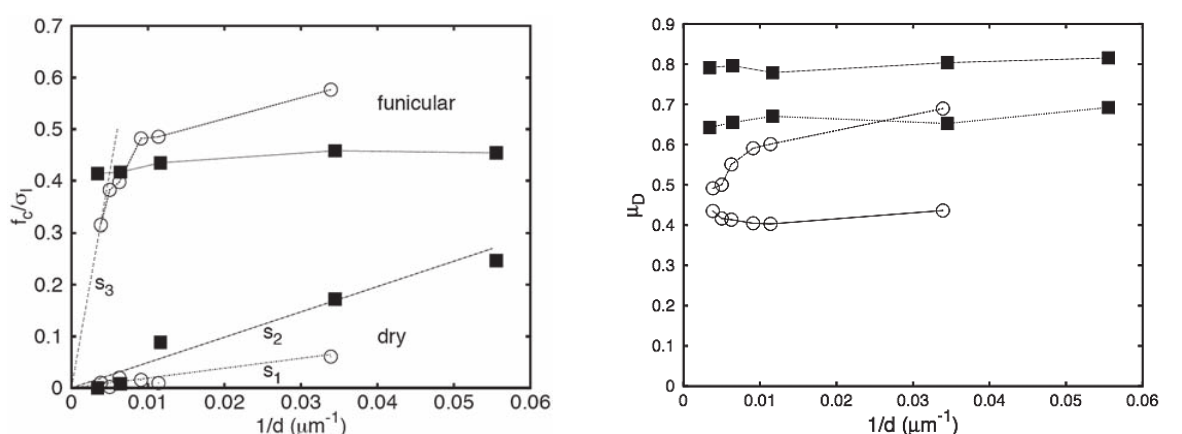
Fig. 5 Inverse of the one-point Flow Function of calcites and glass beads (left) or coefficient of dynamic friction (right) as a function of the inverse of the mean diameter for dry and funicular states. Squares: calcites, circles: glass